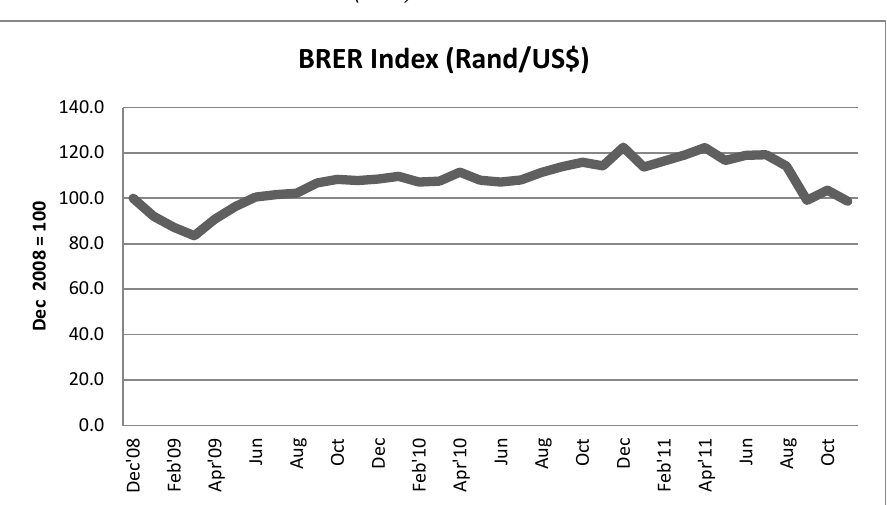
FIGURE 2a: Bilateral Nominal and Real Exchange Rates Source: Reserve Bank of Zimbabwe (2009)